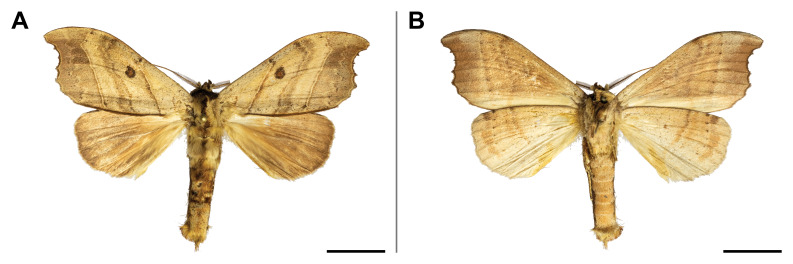
Pseudobarobata
integra Kiriakoff, 1966. A. dorsal view; B. ventral view. The scale bar represents 1 cm.